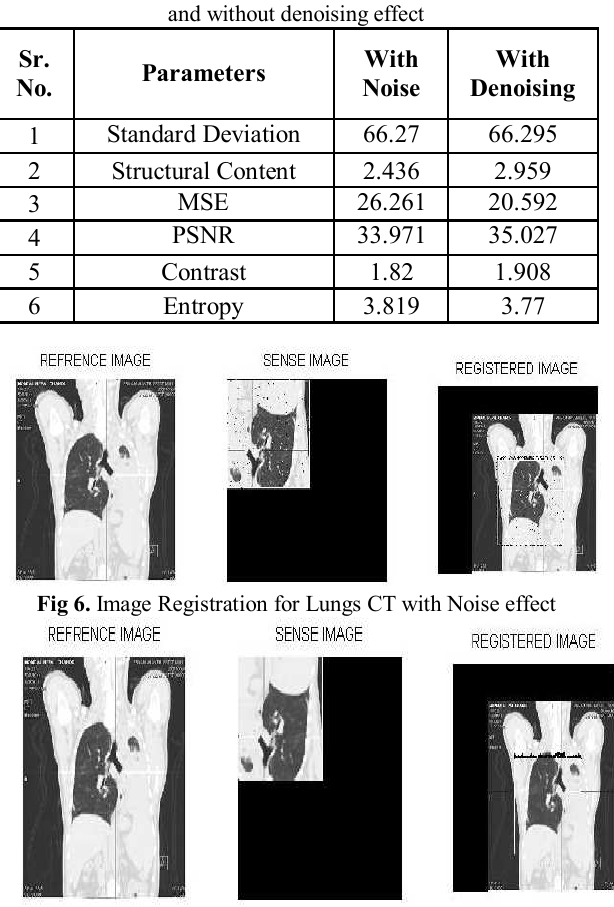
Table 2 . Abdomen CT: Comparision of registered image with